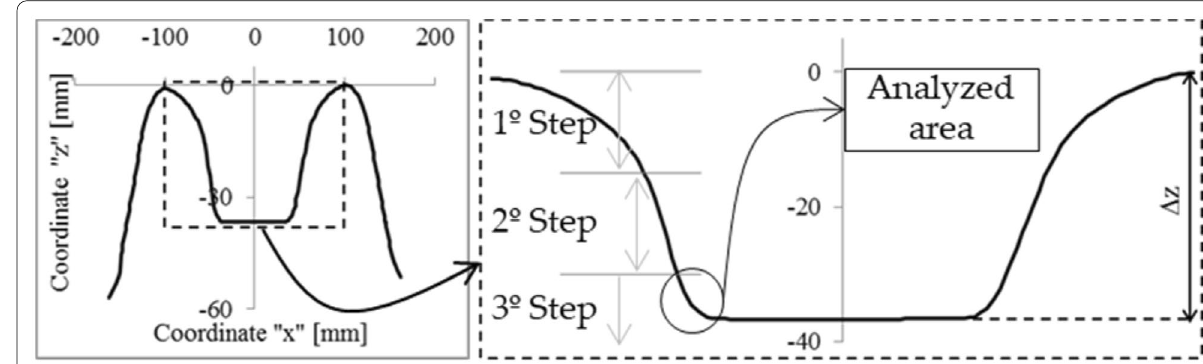
Figure 15 Final geometry of the workpiece formed with the hybrid process